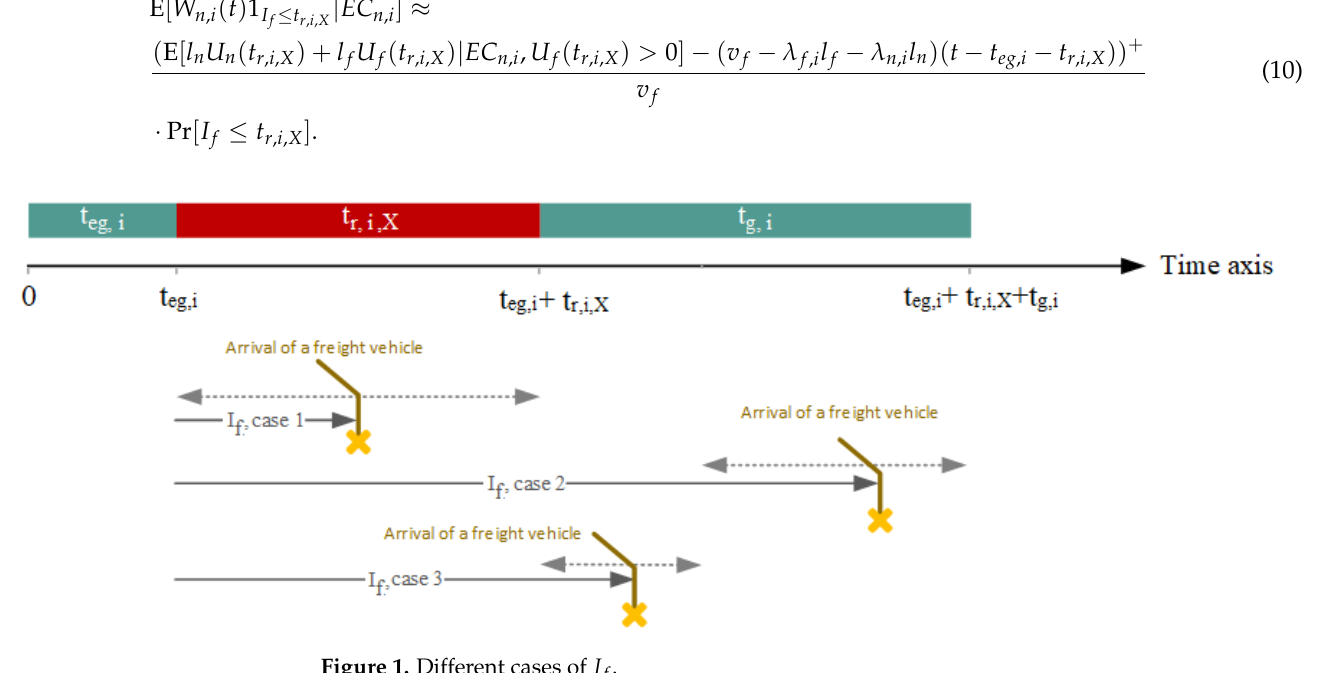
Figure 1. Different cases of I f